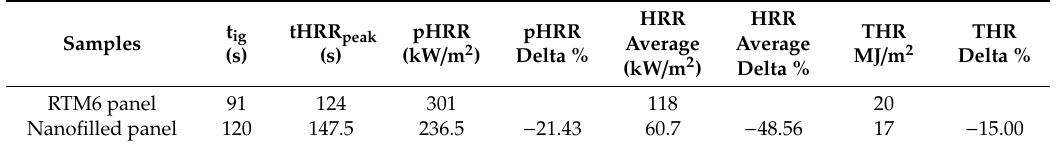
Figure 21. Heat release rate (HRR) of the composite obtained with the nanofilled resin to RTM6 panel. Table 1. Comparison of parameters by cone calorimeter test: time to ignition, tig, HRR results, and total heat release (THR) for measurements performed at irradiance 35 kW/m 2 .